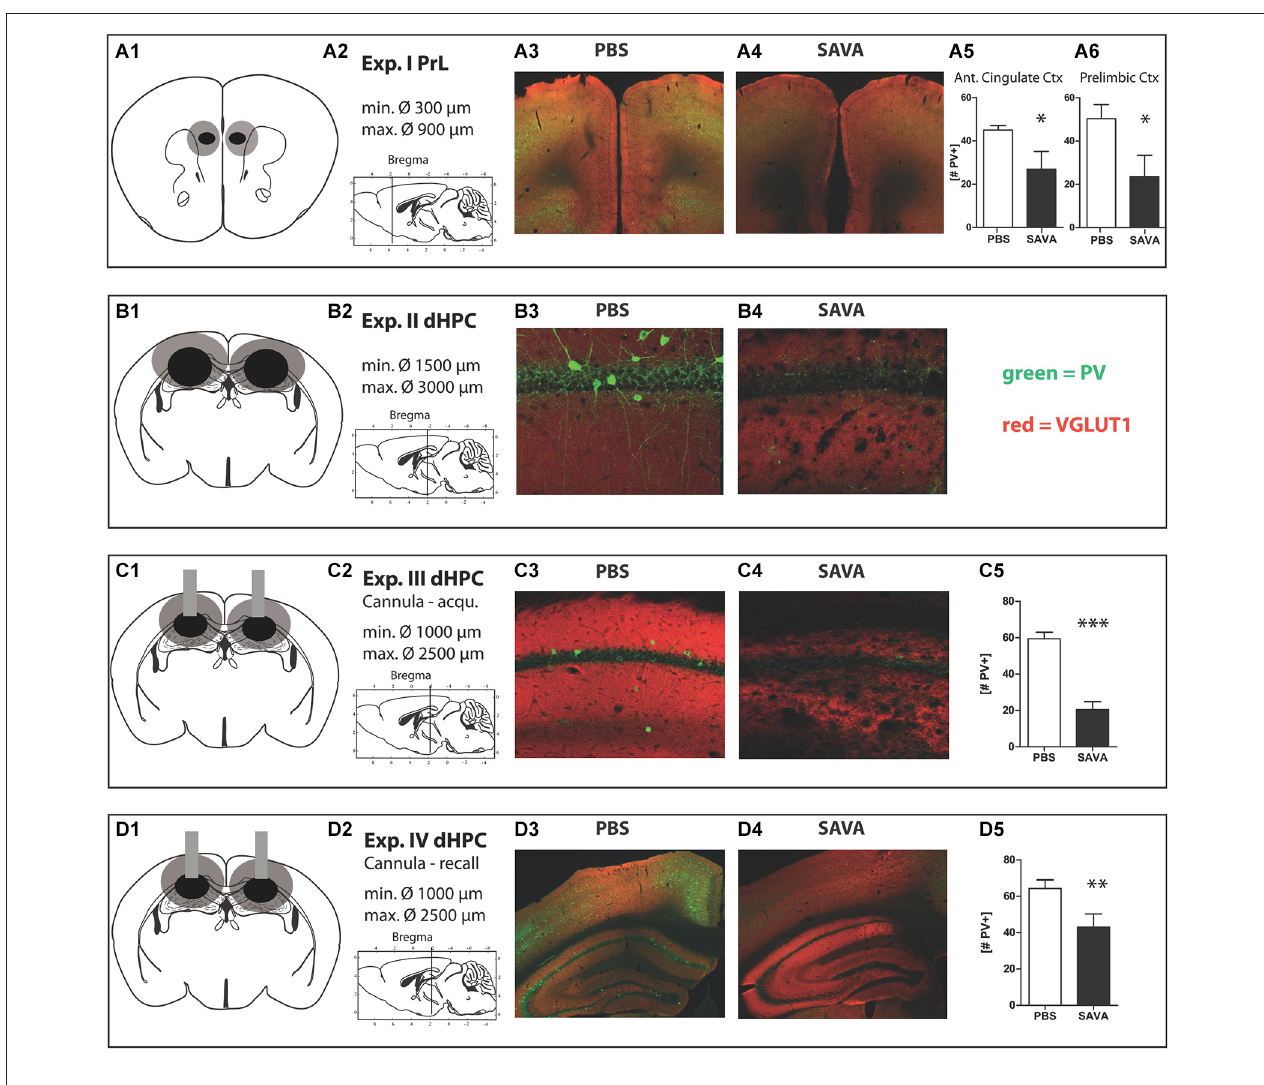
FIGURE 6 | Histology Experiment I through IV: (A1 + 2–D1 + 2) respective location and extension of lesions for Experiment I–IV ; (A1–D1) lesion extent: black = smallest occurring lesion, gray = biggest occurring lesion; (A3) representative image of prelimbic region of PBS-treated mouse; (A4) representative image of prelimbic region of SAVA-treated mouse; (A5 + 6) quantification of parvalbumin positive cells (PV+) in anterior cingulate cortex and prelimbic cortex, respectively; (B3) representative image of CA1 region of PBS-treated mouse; (B4) representative image of CA1 region of SAVA-treated mouse;